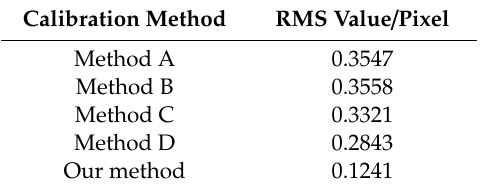
Table 6. The RMS value of reprojection error of the five calibration